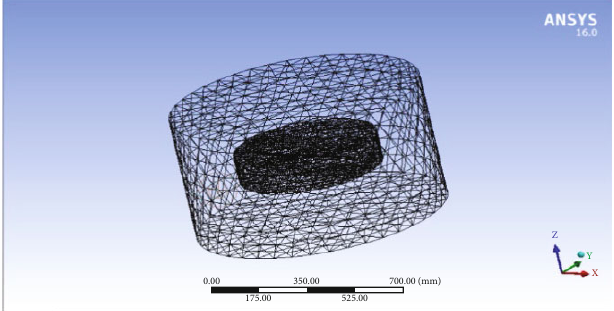
Figure 15: Design-2 (generated mesh). Mesh type: unstructured tetrahedral mesh. Nodes: 759610. Elements: 482119.